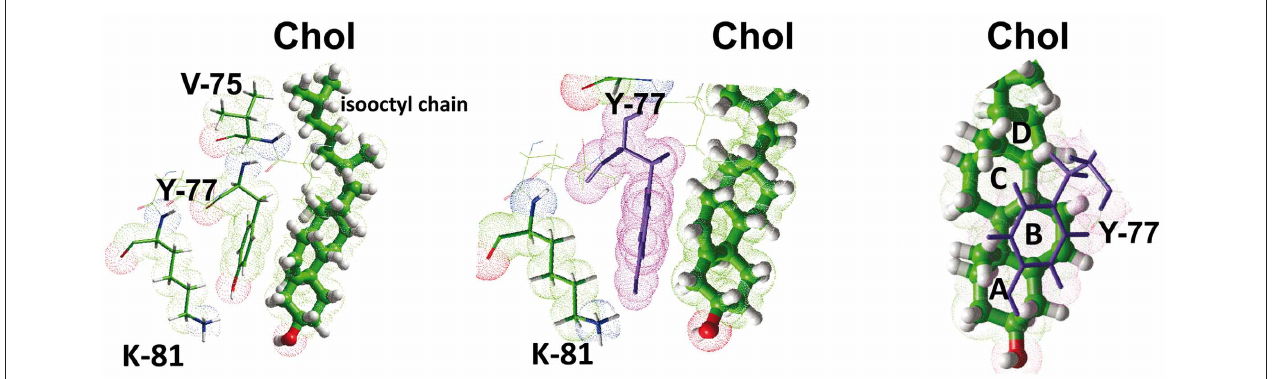
FIGURE 5 | Molecular mechanisms of cholesterol-CRAC interaction. This figure shows a detailed analysis of the interaction between cholesterol and the CRAC domain of the human delta-type opioid receptor (see Figure 4 ). Three distinct views of the complex are shown, with residues I-74, Y-77, and K-81 enlightened. The NH + 3 of K-81, and the OH groups of Y-77 and cholesterol are rejected in a polar area where